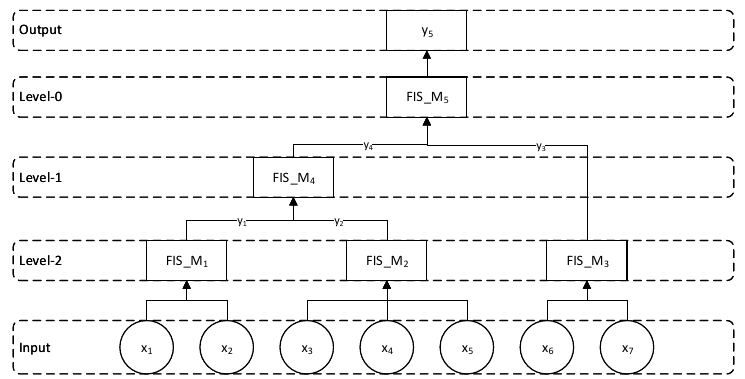
Figure 3. General Hierarchical Fuzzy Inference